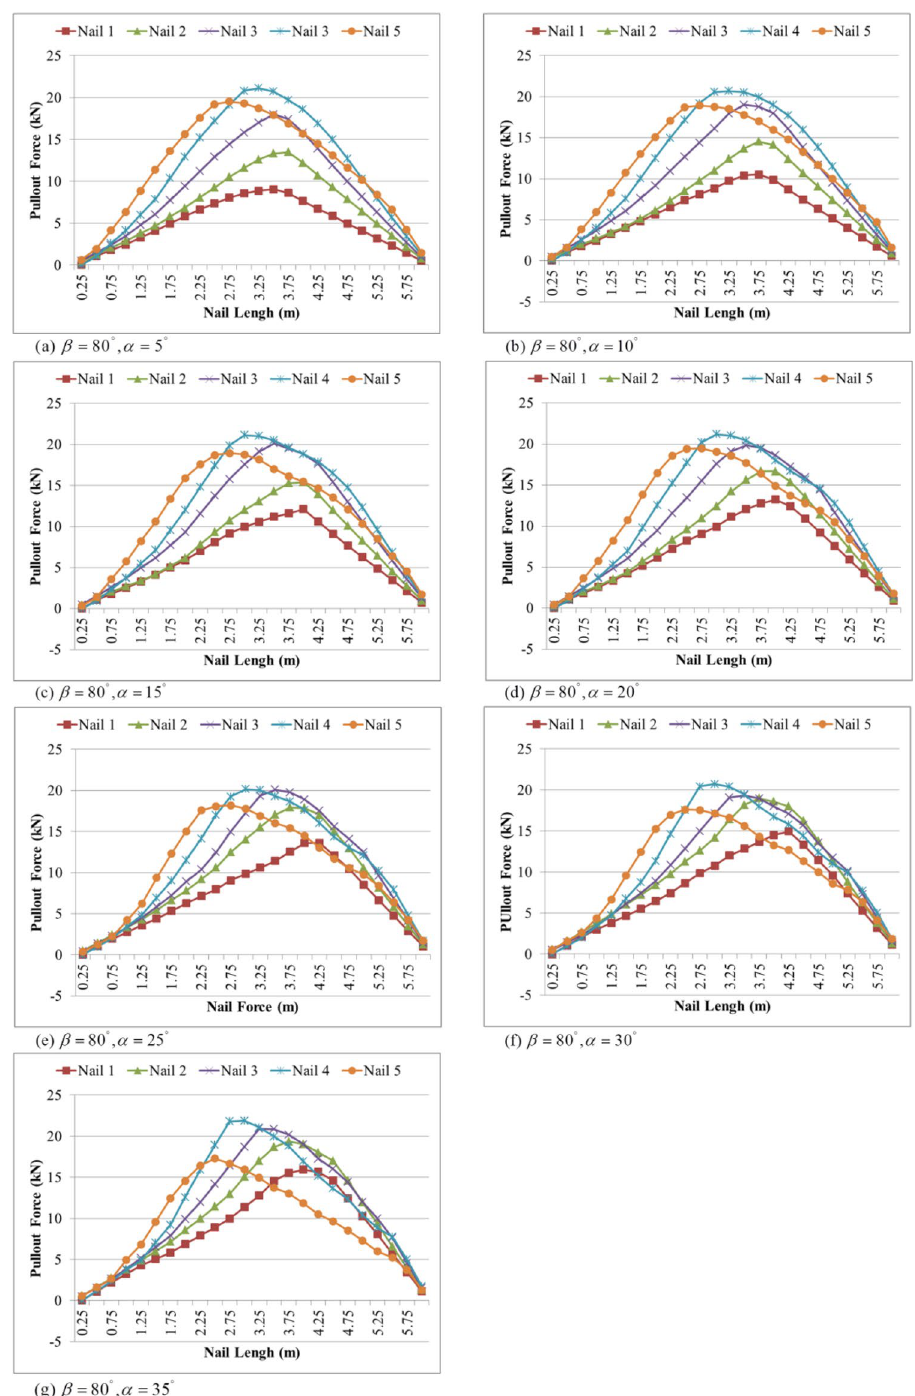
Fig. 9 Plots of the maximum pull-out force of nails in terms of the nail length with nails installed in the slope which has an angle of β = 80°, and at dif- ferent angles ( α = 5° to α =